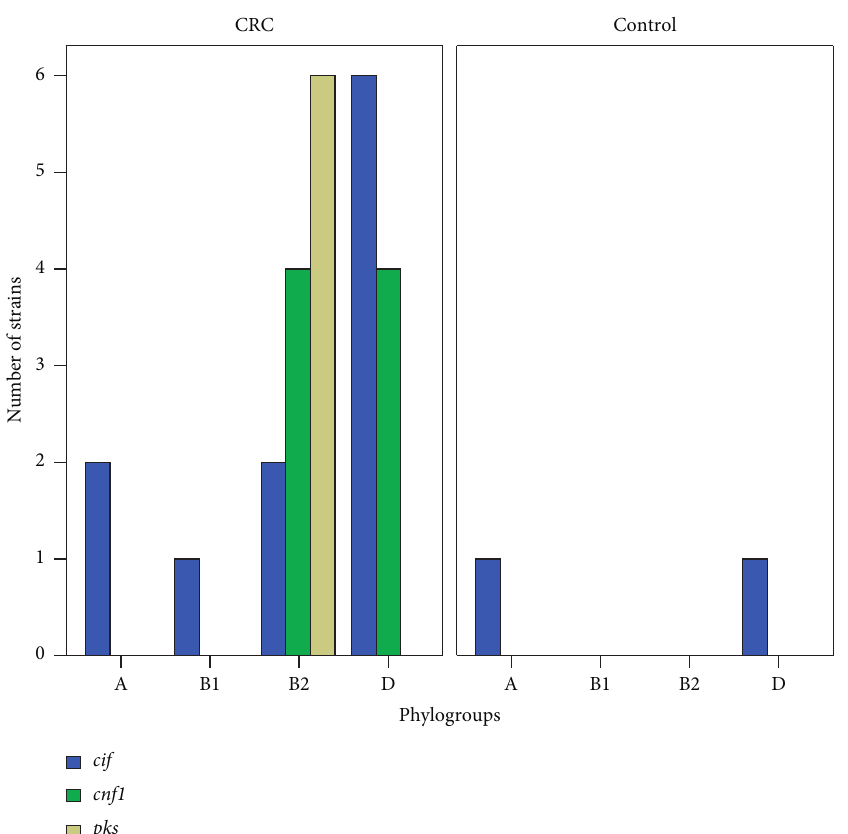
Figure 2: Distribution of cyclomodulin-positive E. coli in various phylogenetic groups.